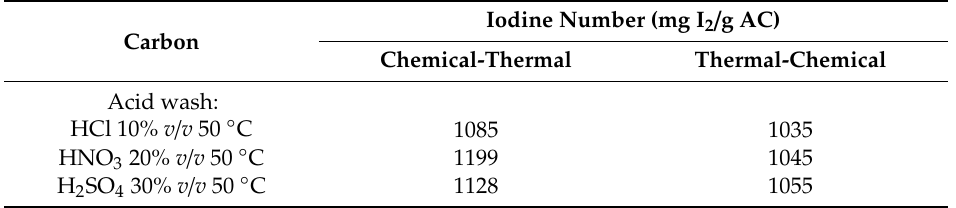
Table 3. Iodine number (mg I 2 / g AC) of two sequences of reactivation (chemical-thermal and